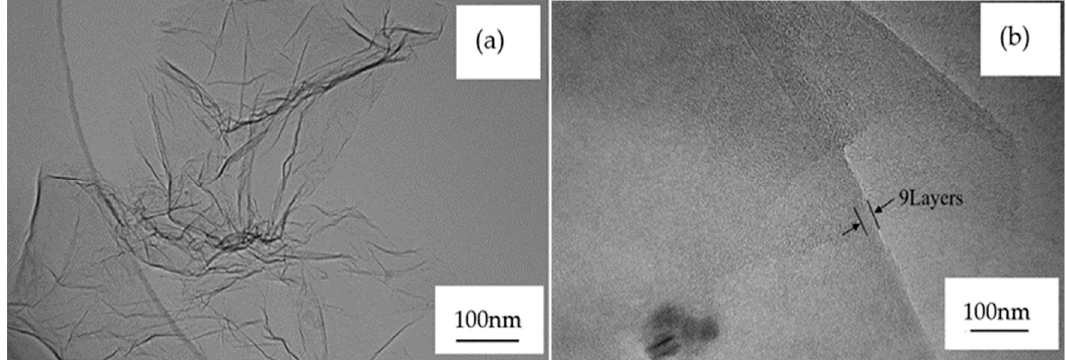
Figure 3. TEM images of fuel-modified graphene. ( a ) The micrograph of graphene after DBDP-assisted ball milling for 10 h; ( b ) The graphene sheets after DBDP-assisted ball milling for 10 h.